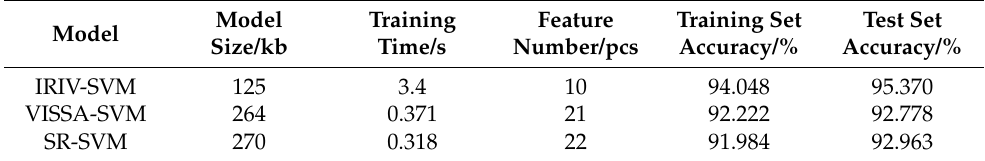
Table 3. Comparison of SVM classification models based on feature selection.